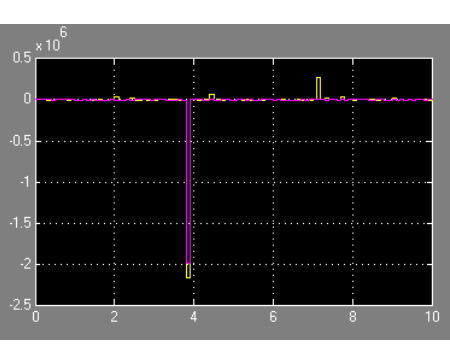
Figure 6. model with using ANN of Scope 3 ‘G 2 (u)’